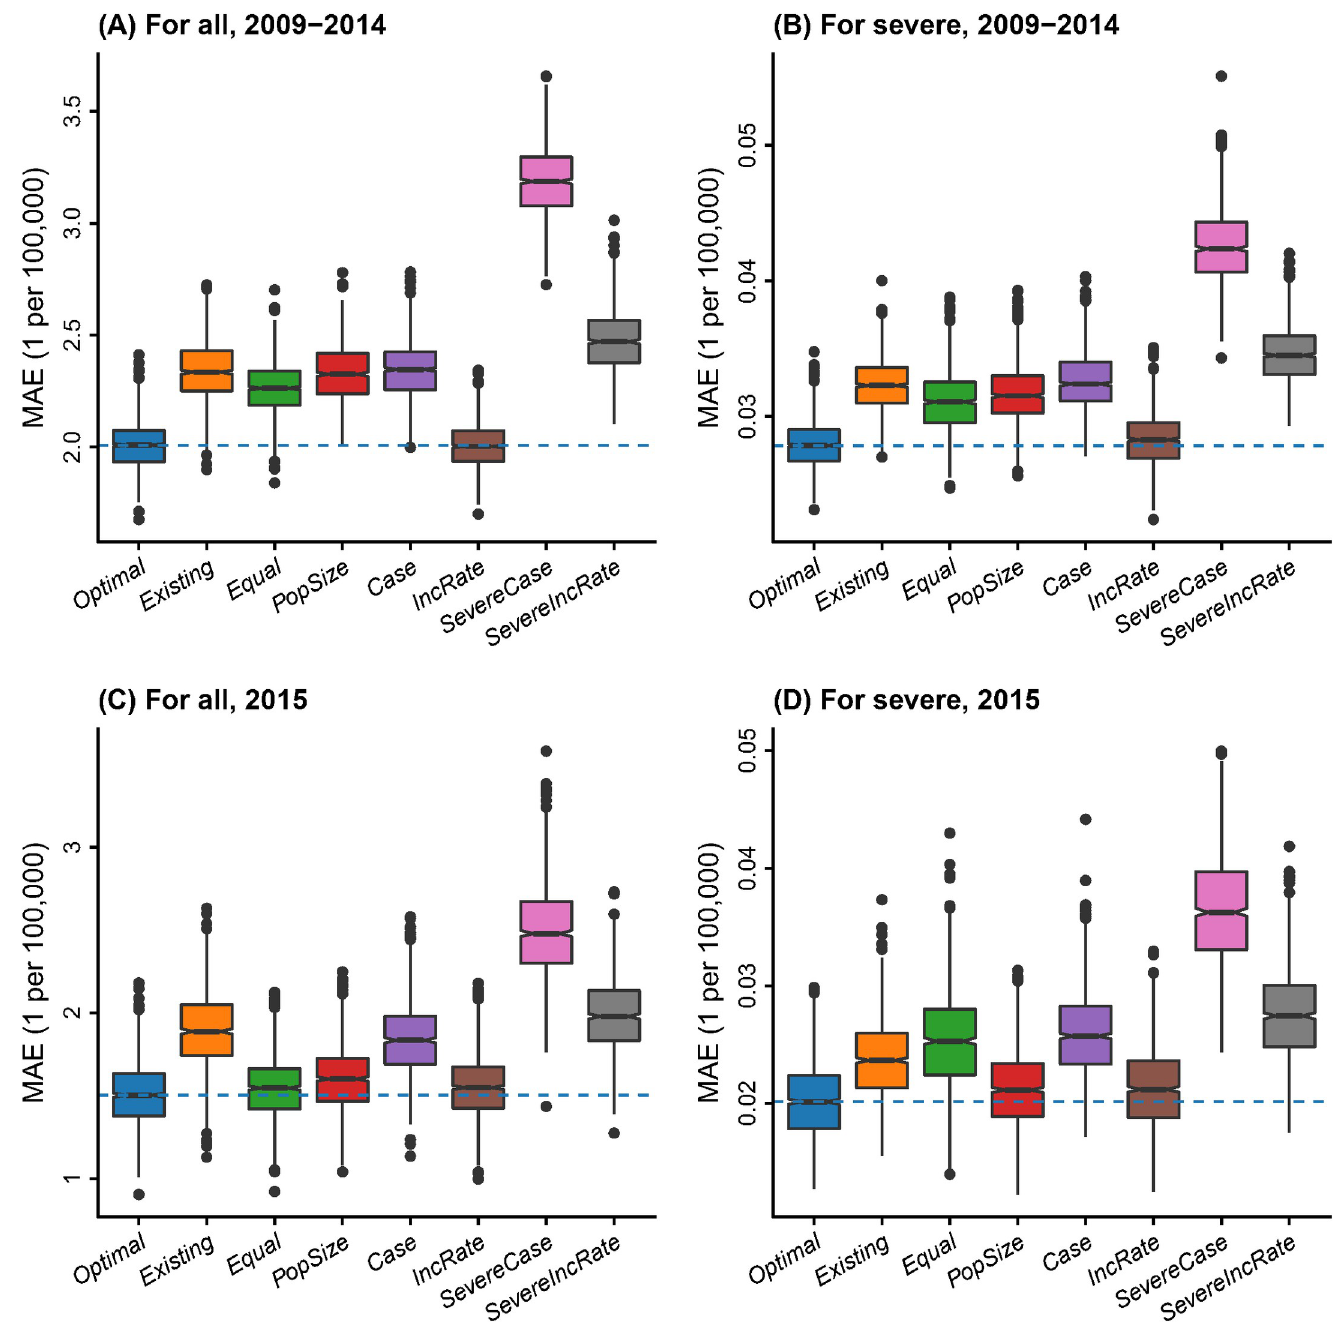
Fig 5. Surveillance performance of the optimal design and the seven archetypal designs evaluated with data from 2009–2014 and 2015 over 1000 realizations of the disease system model. Violin plots and boxplots for different designs (shades of color) show the distribution of mean absolute error (MAE) in estimating serotype-specific incidence rates of (A) all cases and (B) only severe cases using 2009–2014 data; and (C) all cases and (D) only severe cases using 2015 data, which was not used in the optimization procedure. The horizontal dashed lines show the median MAEs of the optimal